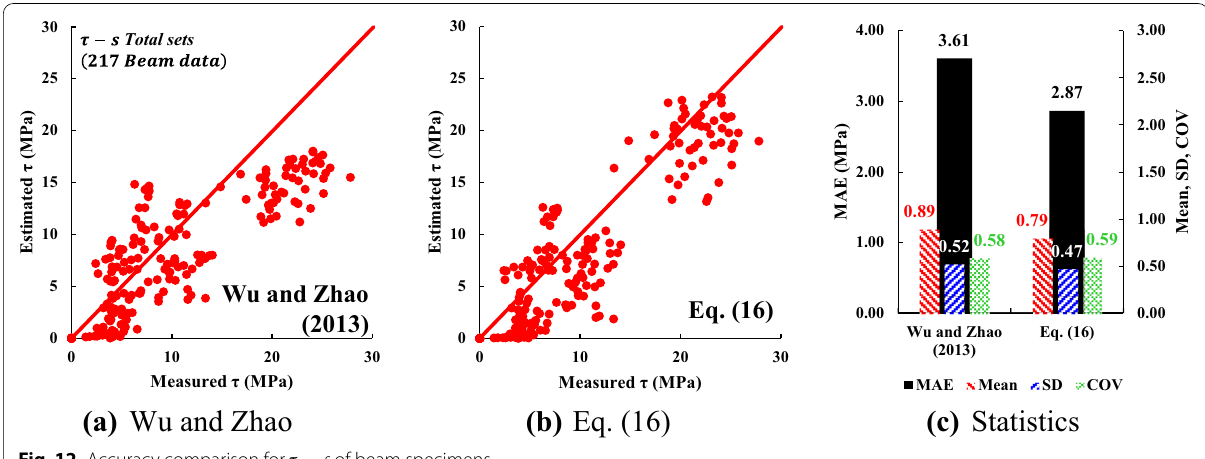
Fig. 12 Accuracy comparison for τ − s of beam